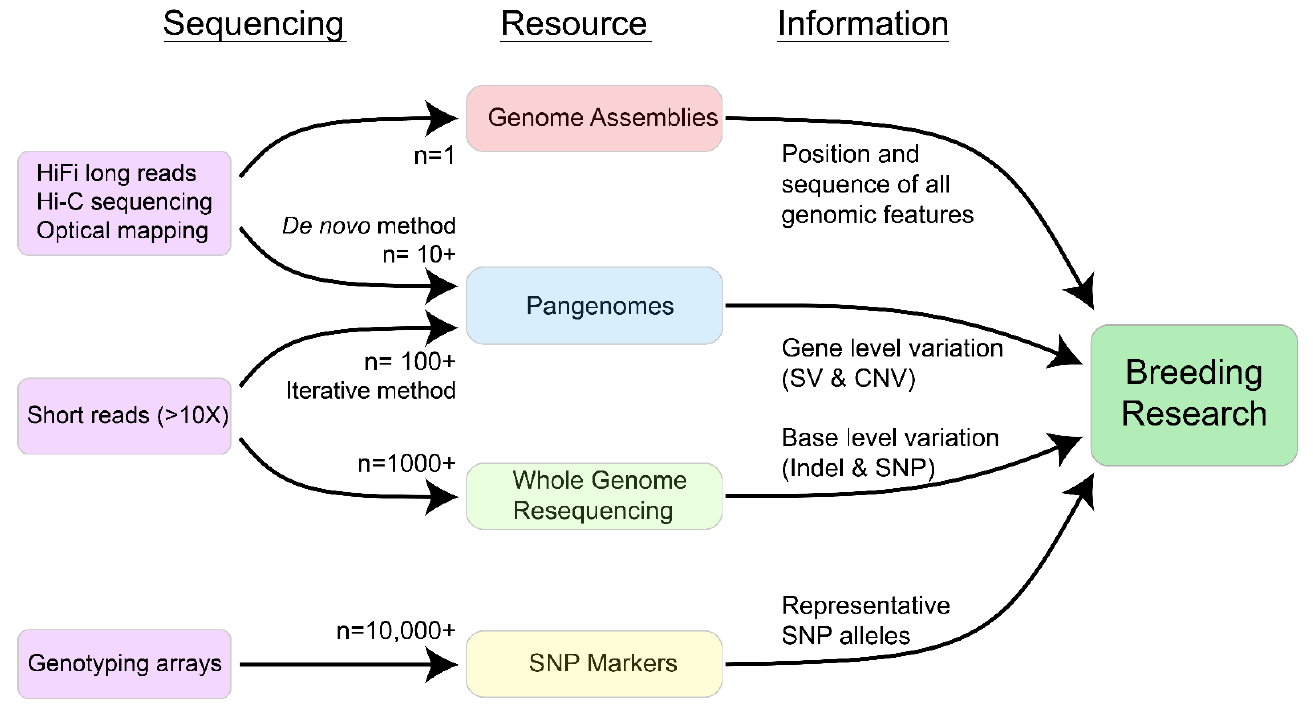
Figure 1. Sequencing required and information gained from core genomic resources for soybean breeding research (n—number of individuals included in a typical